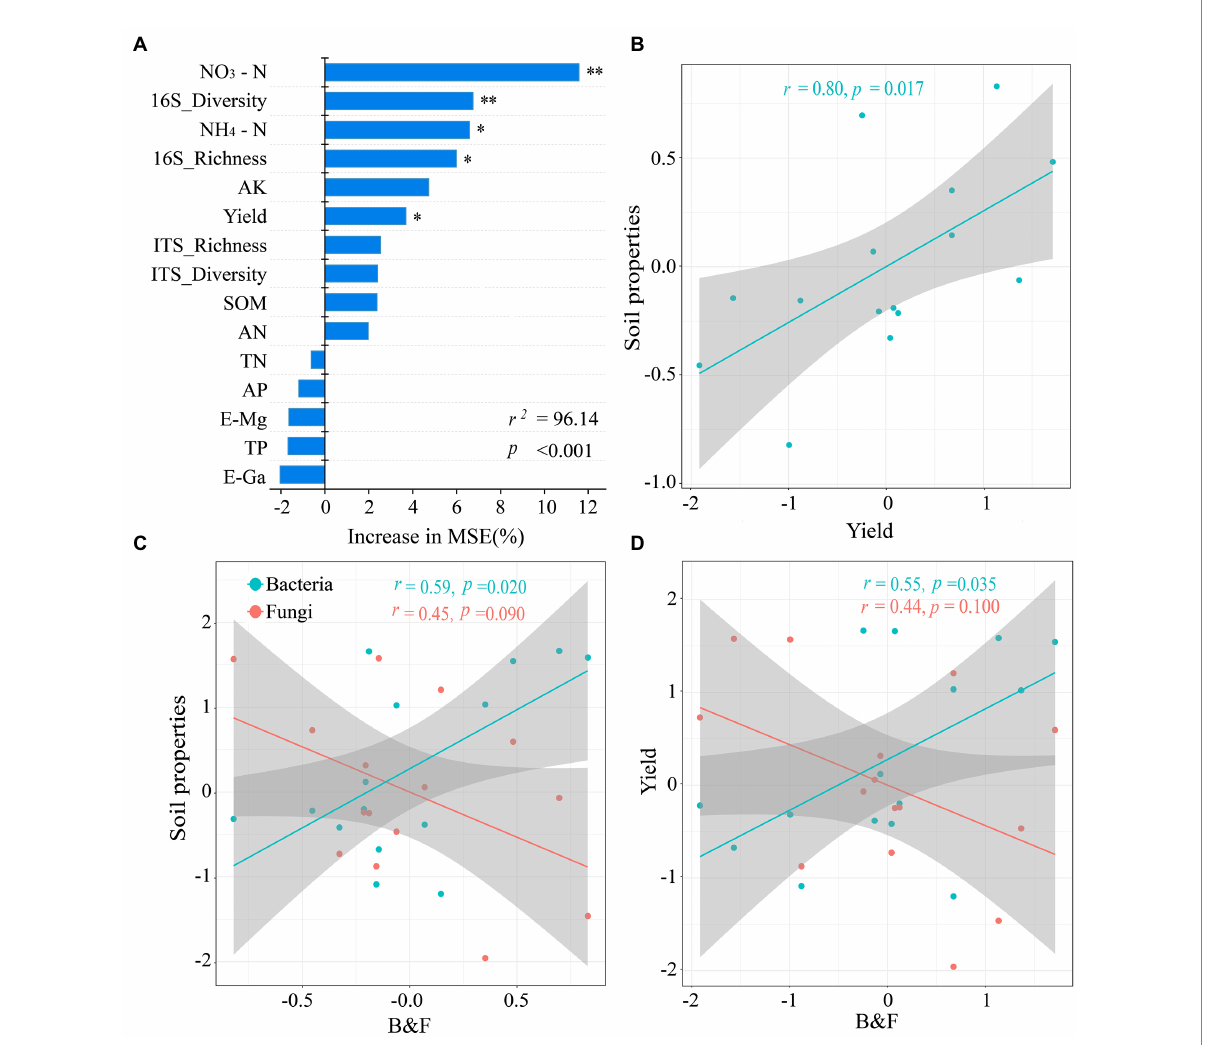
FIGURE 6 (A) Random Forest model showing the importance of predictors under different fertilization treatments. (B-D) Regression analysis after standardization (Z-Score) of the data showed a two-by-two linear relationship between soil properties, microorganisms and crop yield. MSE: mean square error. * p < 0.05, ** p < 0.01 indicates a significant correlation between the